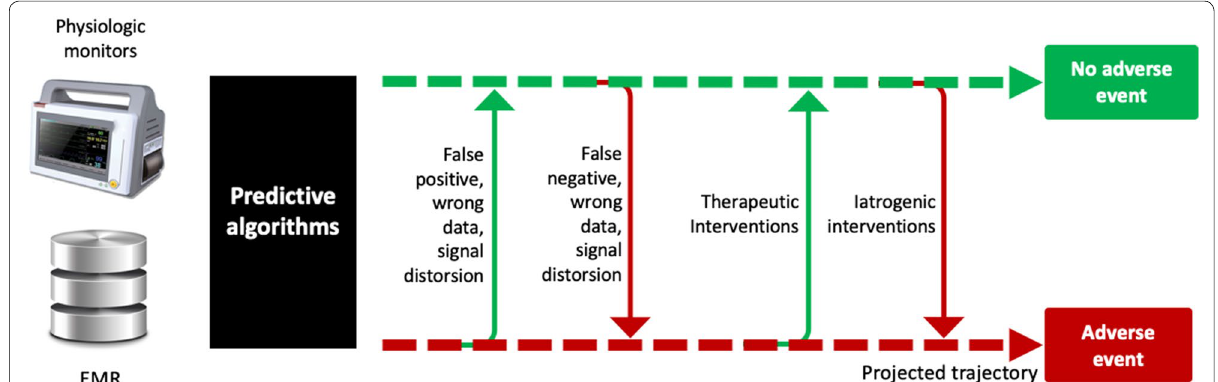
Fig. 1 Factors susceptible to affect the predictive value of machine learning algorithms. EMR arrow projected trajectory, plain arrow =